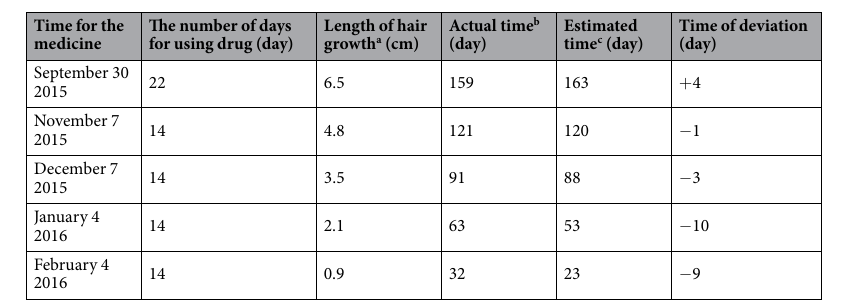
Table 3. Comparison of actual and estimated time of drug entering body. a Length of hair growth during a period of using drug and sampling. b The time interval between using drug and sampling. c The time calculated by the formula.